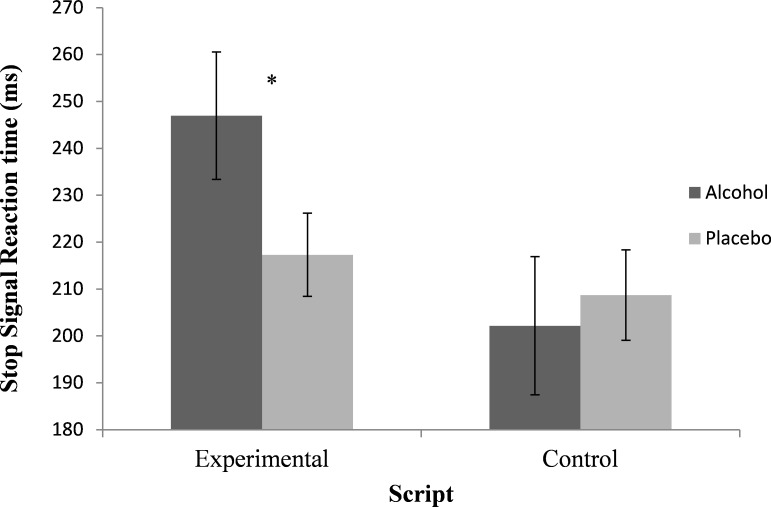
Mean integrated SSRT’s (ms) following alcohol and placebo for both the experimental and control condition.Values are mean ± SEM, *script compared to control condition (*p = .012).